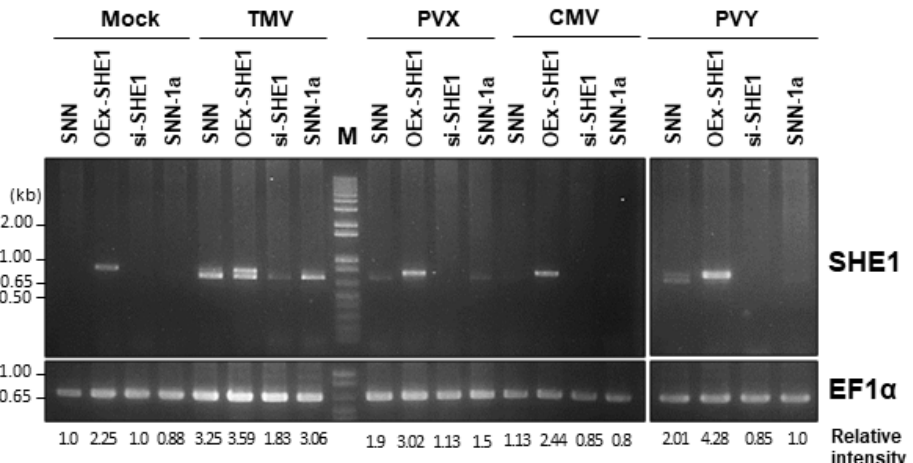
Figure 1. Semi-quantitative RT-PCR for levels of SHE1 mRNA accumulation, at 3 days post inoculation. Plants were either nontransformed tobacco cv. Samsun NN (SNN) or transgenic tobacco plants generated for over-expression of SHE1 (OEx-SHE1), silencing of expression of SHE1 (si-SHE1) or expression of the CMV 1a protein (SNN-1a). Plants were either mock inoculated (Mock) or inoculated with TMV, PVX, CMV or PVY. The RT-PCR reactions used EF1 α as a reference gene. M = 1 kb plus DNA Ladder (Invitrogen, Carlsbad, CA, USA). Since 35 cycles were found to be saturating, 25 cycles were chosen for the PCRs [17].